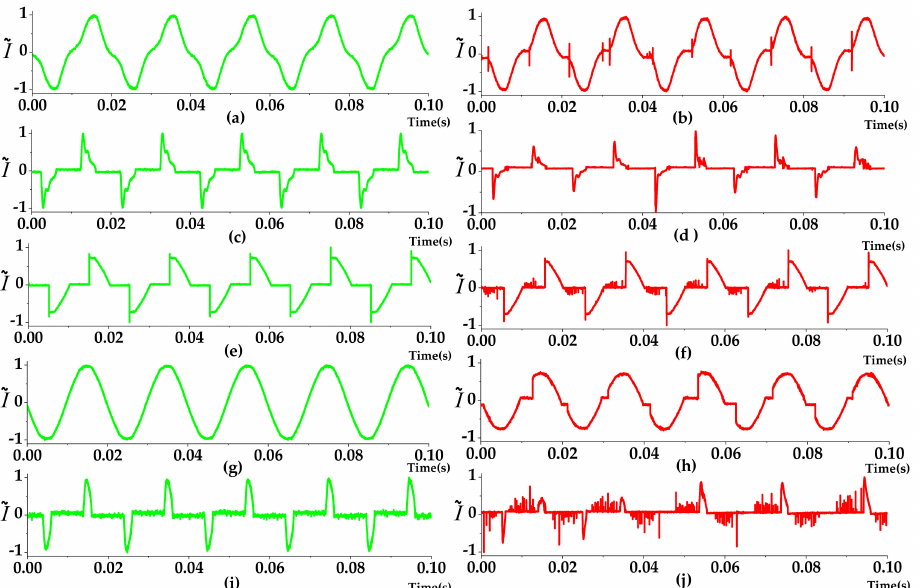
Figure 2. Current waveforms of various loads in normal state and arc state. ( a ) Vacuum cleaner_Normal; ( b ) Vacuum cleaner_Arc; ( c ) Fluorescent lamp_Normal; ( d ) Fluorescent lamp_Arc; ( e ) Dimmer_Normal; ( f ) Dimmer_Arc; ( g ) Heater_Normal; ( h ) Heater_Arc; ( i ) Computer_Normal; ( j ) Computer_Arc.